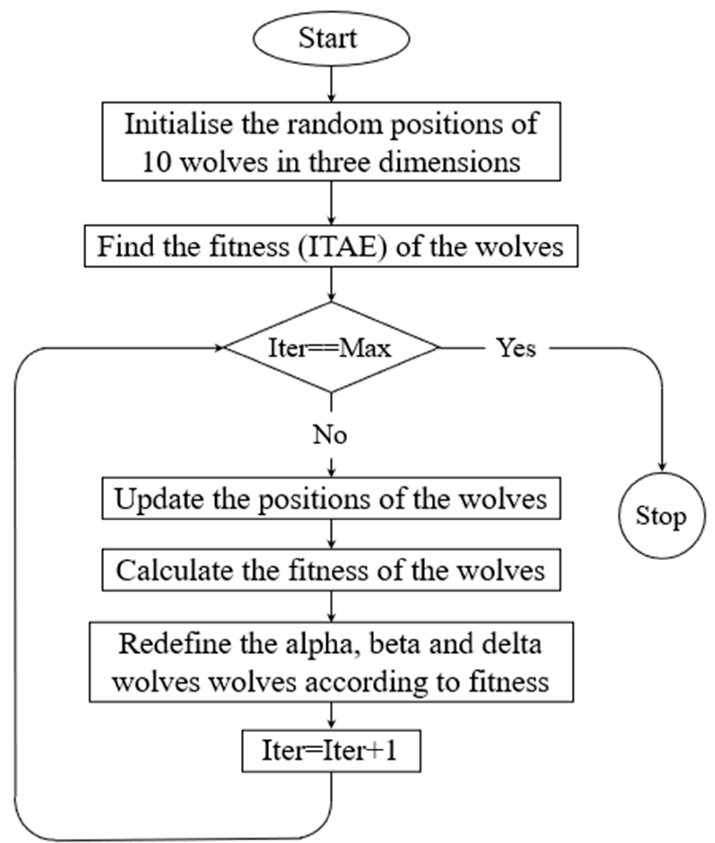
Figure 4. GWO Figure 4. GWO Algorithm.